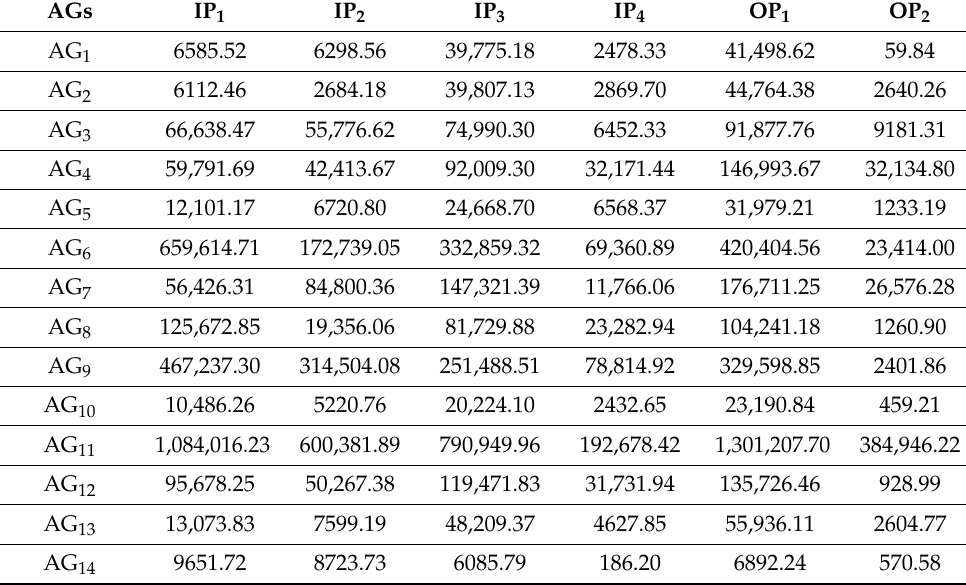
Table 11. Data in 2022 (Unit: 1000 USD).